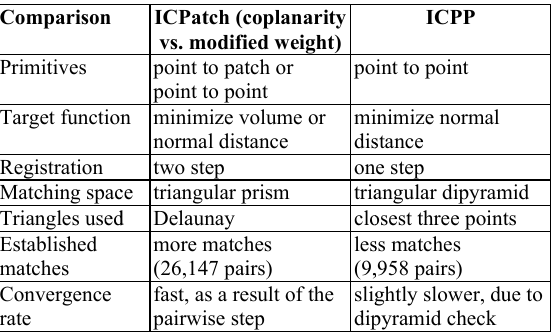
This paper pr surface registr Iterative Close compared agai performance, n were found to The main caus space definitio ICPP uses the Although the favoured over possible mism Voronoi cells. is used in the search space. Future work w for